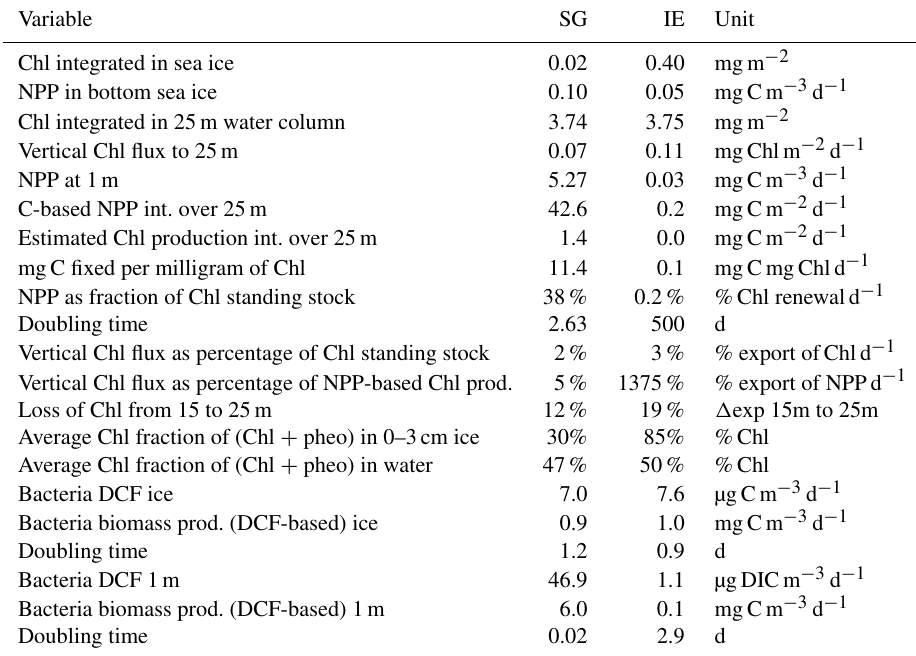
Table 2. Integrated standing-stock biomass of Chl and fluxes of Chl and C, fractions of the different fluxes and standing stocks, and bacterial production based on dark carbon fixation